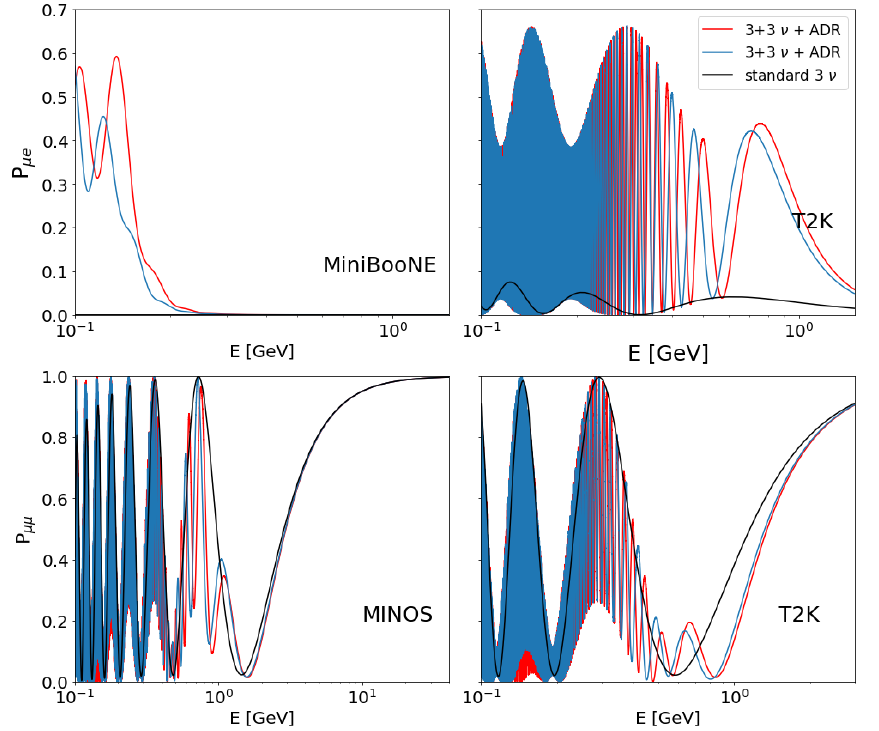
Figure 4 . Comparison between the predictions of the three neutrino standard picture and a 3+3 model with altered dispersion relations for the two sets of parameters mentioned in the main